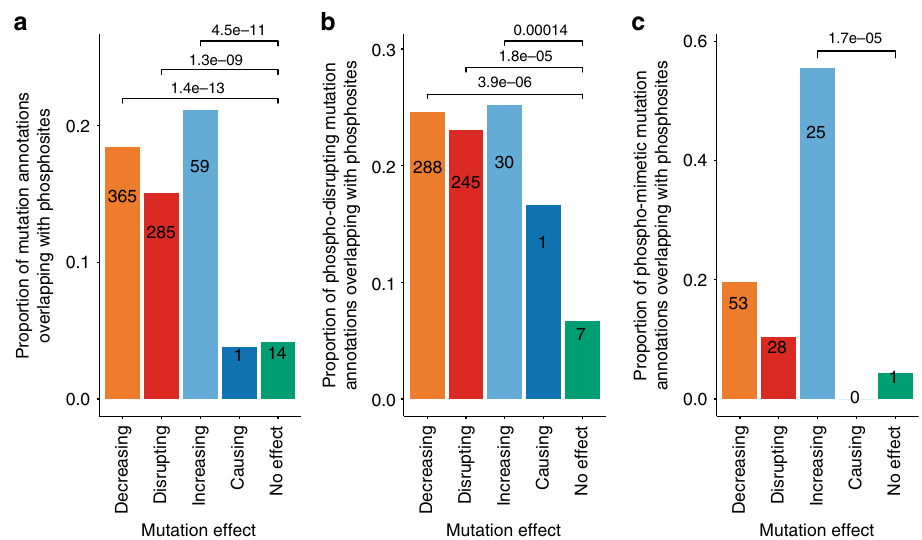
Fig. 5 Overlap between phosphosites and mutation annotations. Overlap of mutation annotations with human phosphosites, as taken from PhosphoSitePlus ® . a Overlap with all mutation annotations in all potential phosphosites; b Overlap with phospho-disrupting mutation annotations; c Overlap with phospho-mimetic mutation annotations. p -values for comparison with the reference ‘ No effect ’ effect type indicated in the fi gure were calculated with Fisher exact test. Source data are provided as a Source Data fi